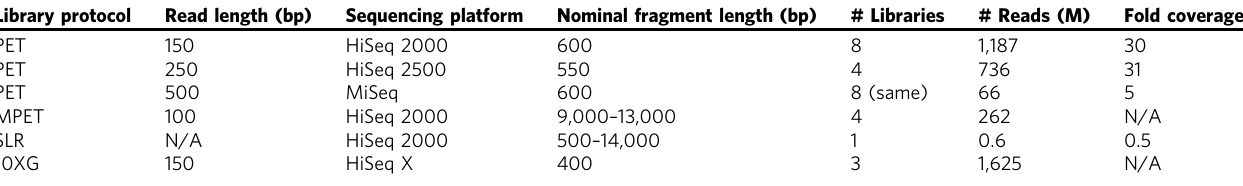
Table 3 Sequencing data for Rana catesbeiana genome assembly Library